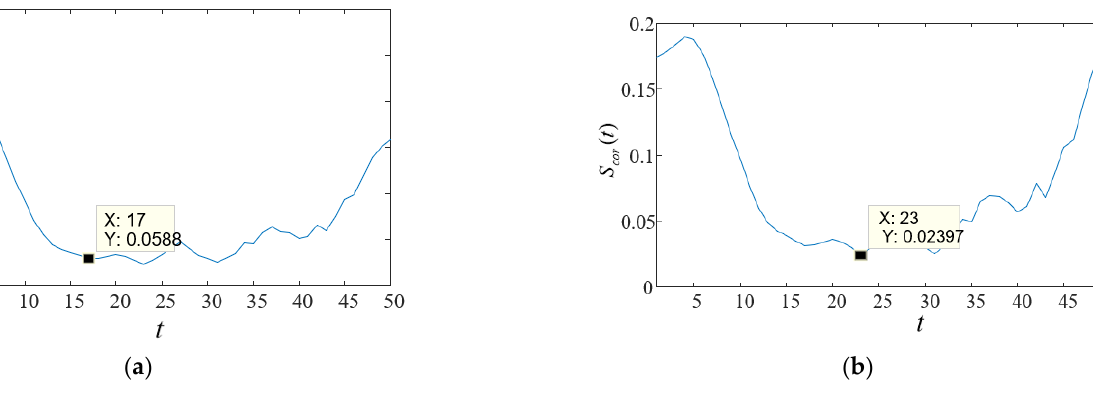
S t . Figure 5. Statistics curves with C-C phase method: ( a ) ∆ S ( m , t ) ; ( b ) S cor ( t ) cor